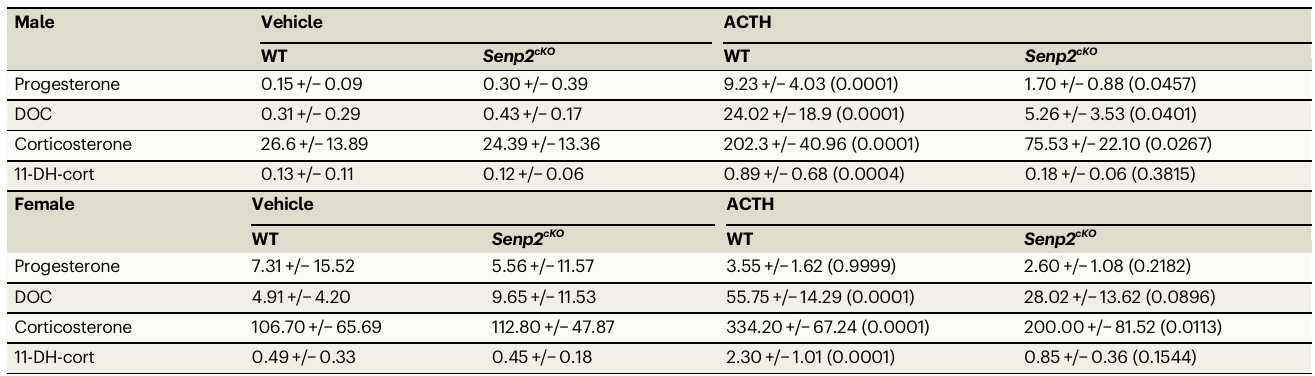
Table 1 | Mean concentration (± SD) of plasmatic steroids in 24-week-old WT and Senp2 cKO mice